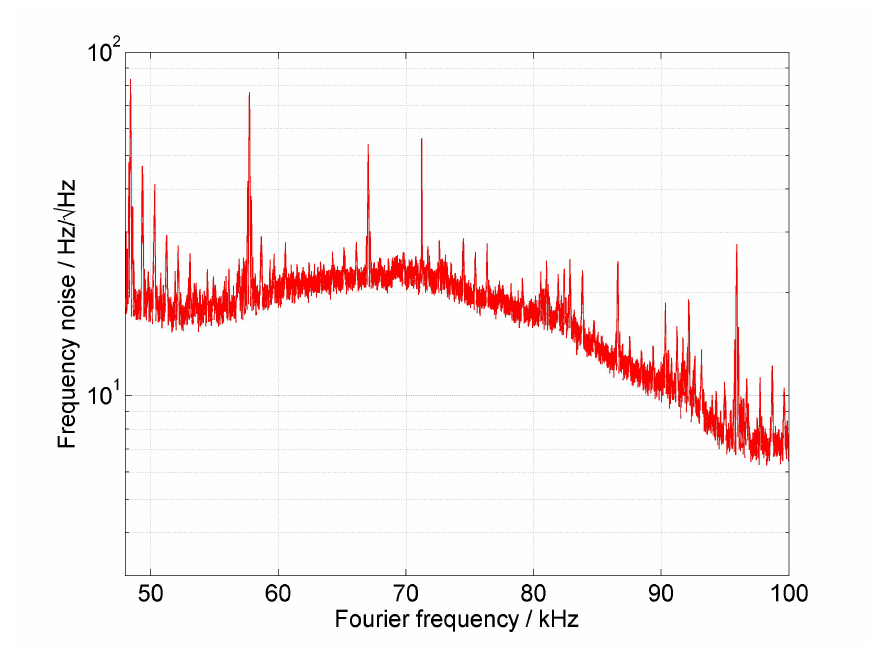
Figure 4. Out-of-loop measurement for stabilized and free-running ORION laser